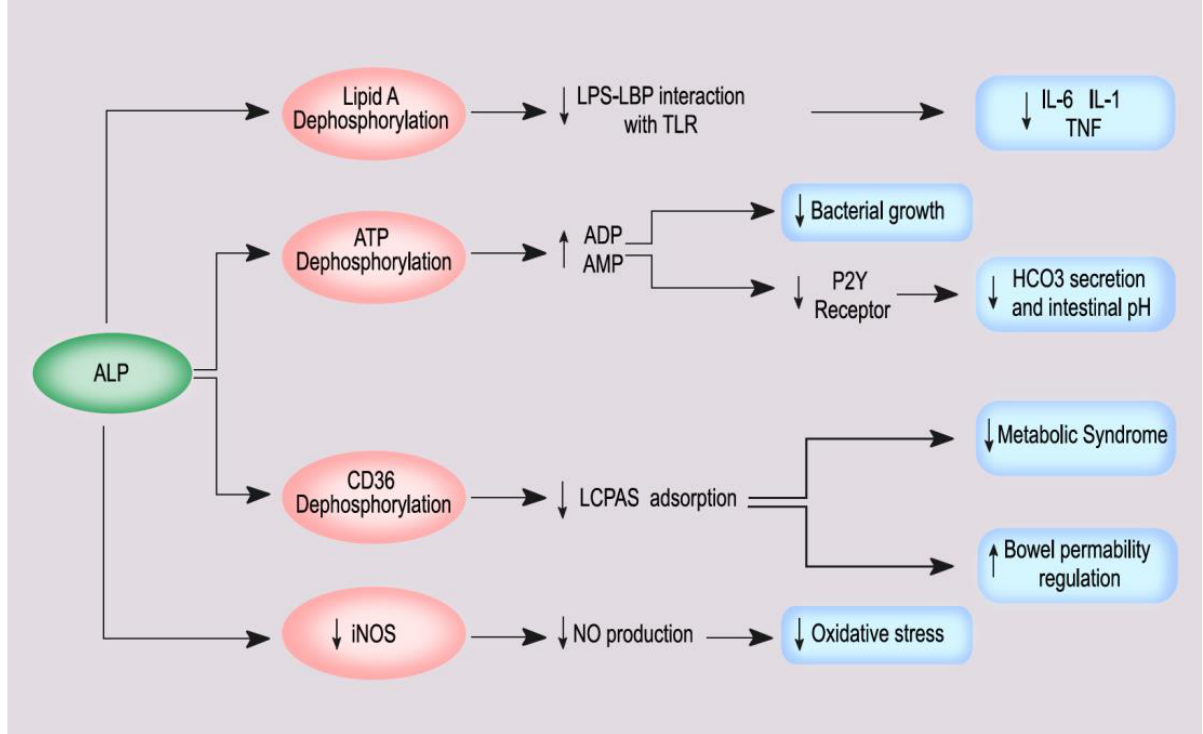
Figure 3. The main pathways of ALP on systemic inflammation, bowel and kidney.